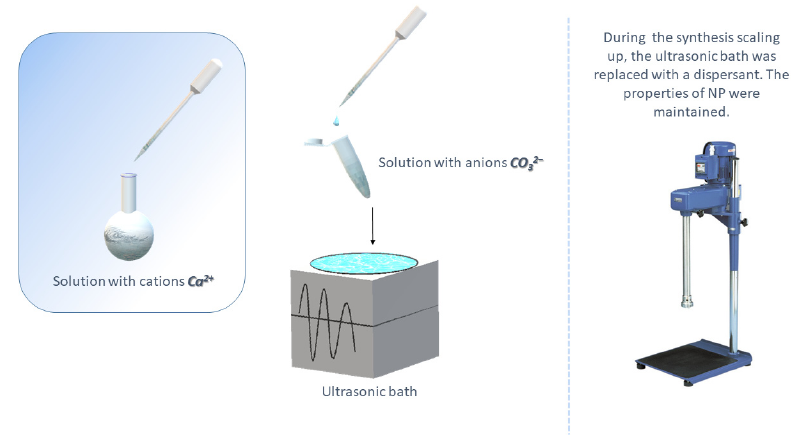
Figure 1. An outline of the fabrication of CaNPs.